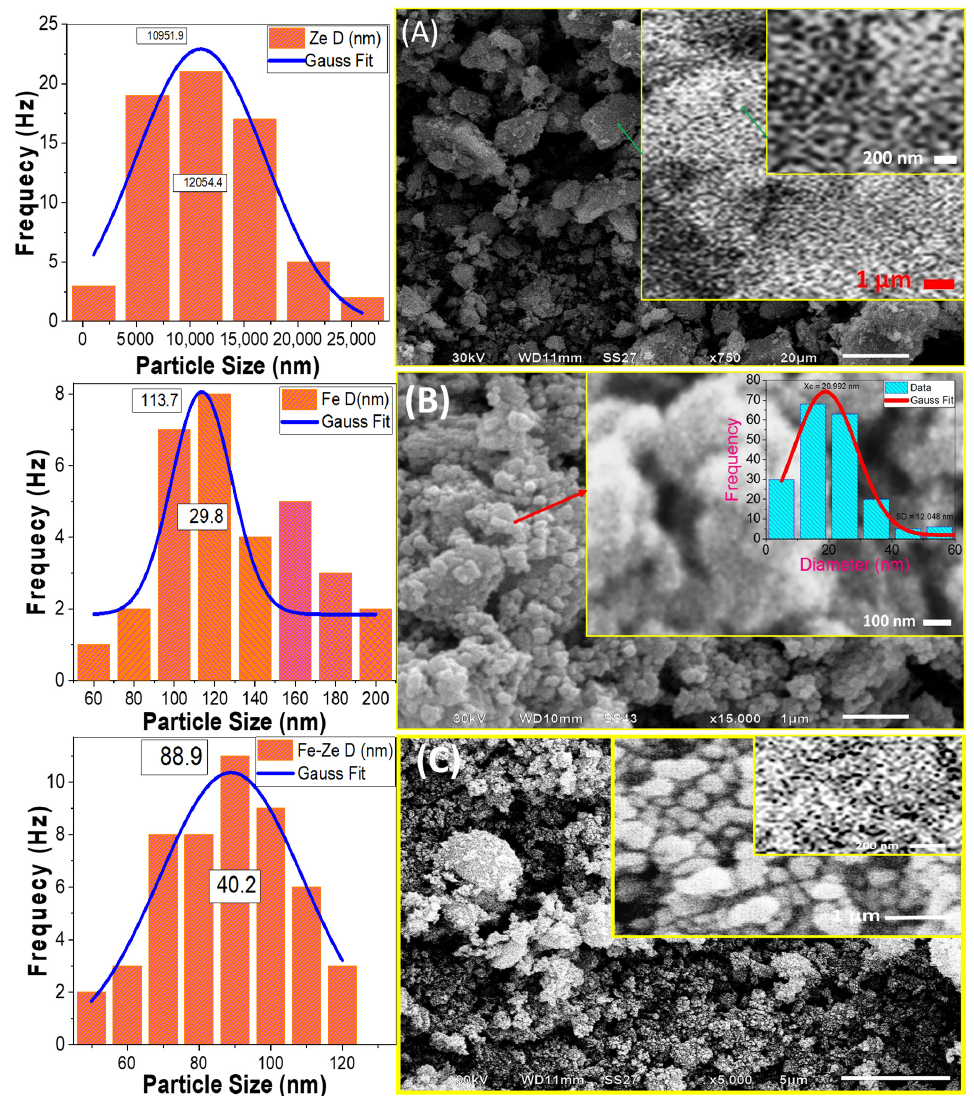
Figure 3. SEM micrographs and the corresponding particle size distribution for ( A ) natural zeolite, ( B ) Fe 2 O 3 , and ( C ) Fe 2 O 3 /zeolite. The inset of ( B ) shows the pore diameter